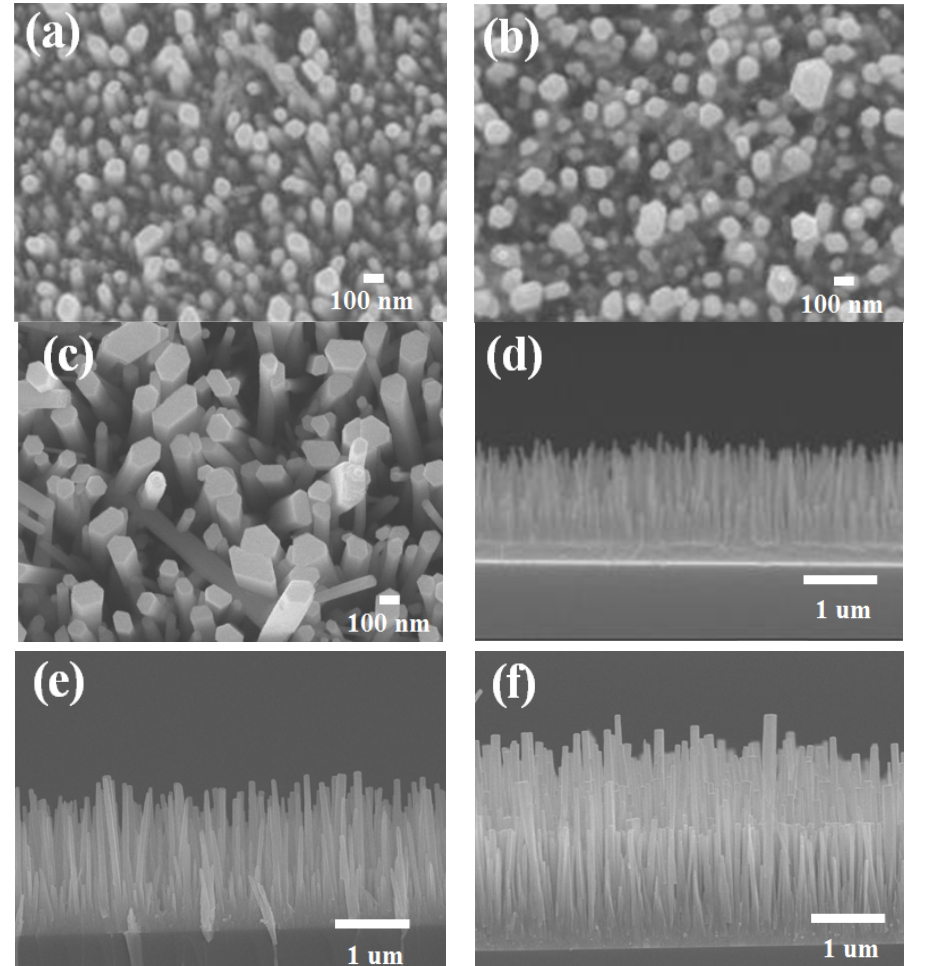
Figure 3. SEM images of ZnO nanorods fabricated under various growth time. ( a – c ) Top-view images of ZnO nanorods grown at 9 h, 18 h, and 27 h; ( d – f ) Side-view images of ZnO nanorods grown at 9 h, 18 h, and 27 h, respectively.